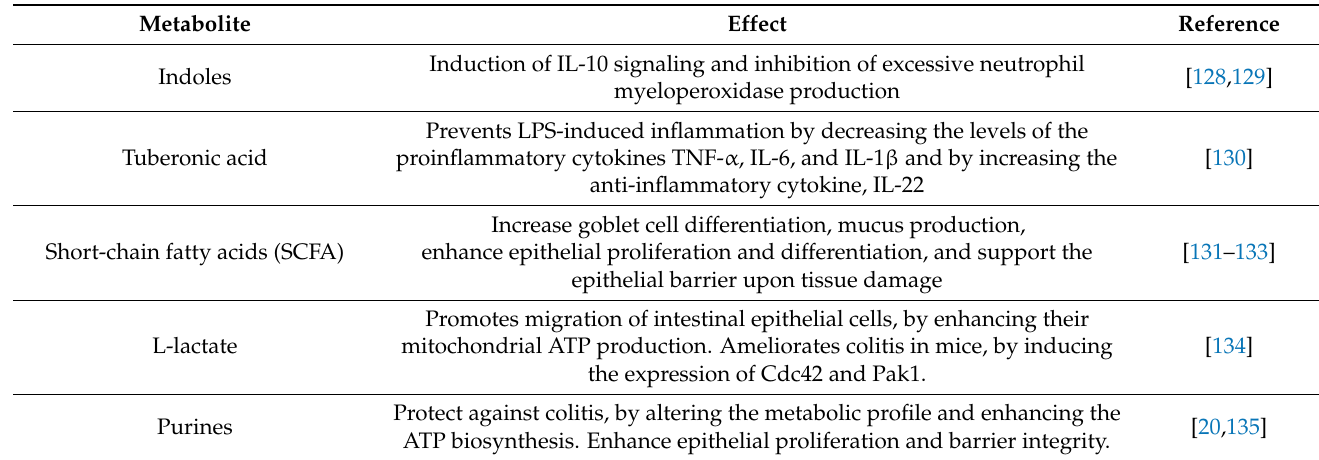
Table 1. Microbiota’s metabolites and their effect of on intestinal wound